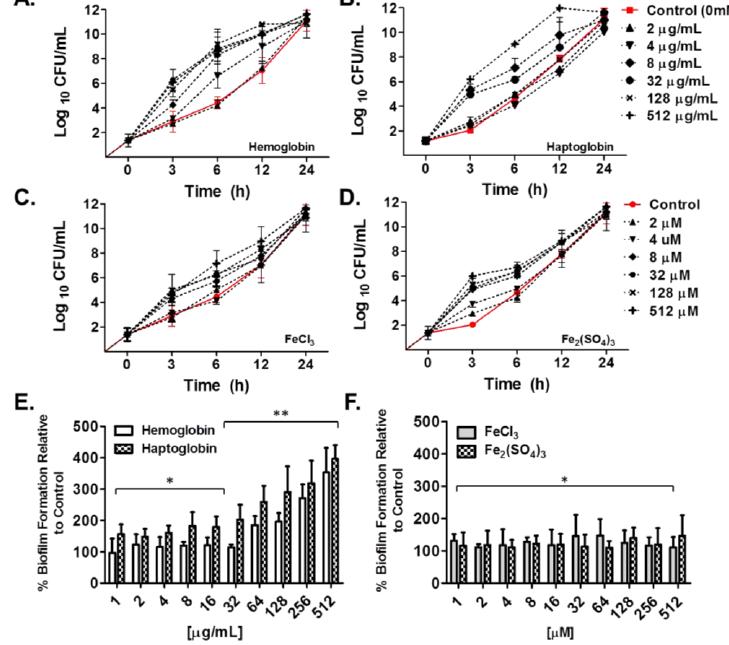
Figure 1. Effect of heme iron and non-heme iron sources on bacterial growth and biofilm formation in vitro . A. baumannii strain 17978 was grown for up to 24 h in MHB II (0.3 g/L) supplemented with increasing concentrations of ( A ) human hemoglobin; ( B ) haptoglobin (0–512 µ g/mL) or ( C ) FeCl 3 , or ( D ) Fe 2 (SO 4 ) 3 (0 to 50 µ M). Growth over time was expressed as the mean log value ˘ SD. Percentage